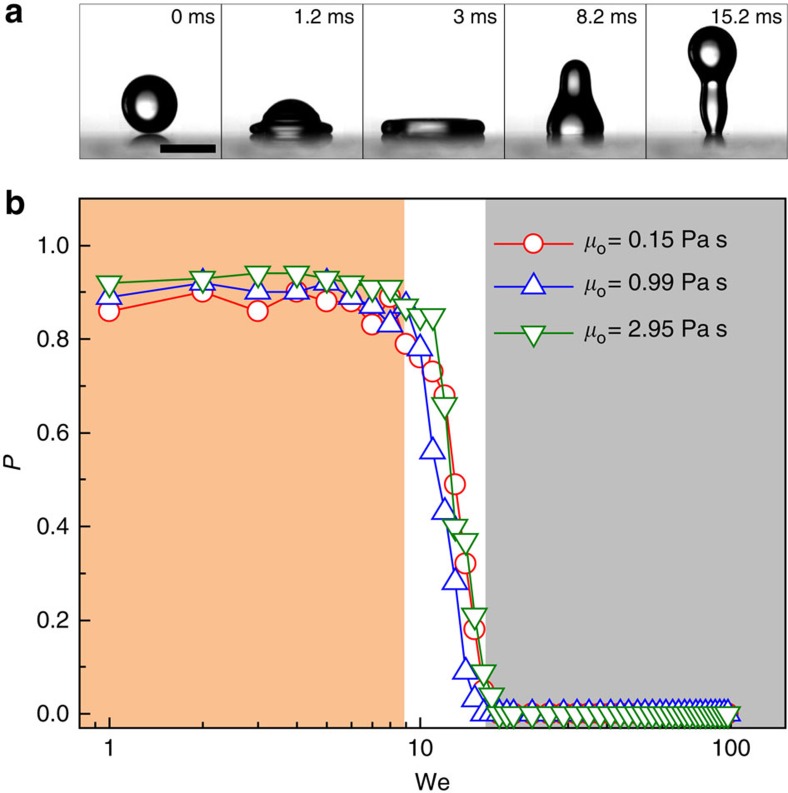
The breakdown of the superhydrophobic-like bouncing.(a) Selected time-lapsed images showing the impacting droplet on composite interfaces (μo=0.15 Pa s and h=50 μm) at We=20. There is no bouncing observed owing to the rupture of air cushion. Scale bar, 2 mm. (b) The variation of the probability P of achieving complete rebound with air entrapment as a function of We on composite interfaces (h=50 μm). For We≲10, the percentage of complete rebound with air cushion entrapment is as high as 75–90%, whereas it drops down to nearly zero for We≳18.